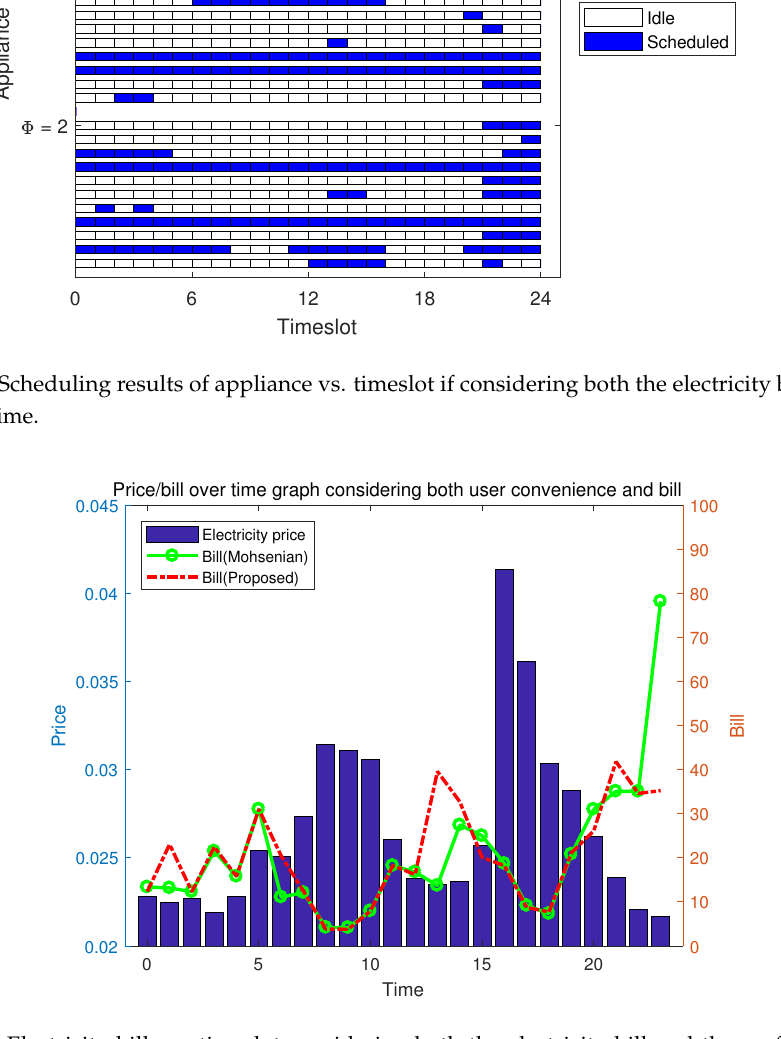
Figure 14. Electricity bill vs. timeslot considering both the electricity bill and the preferred time. The bar is real-time pricing and the plot is the electricity